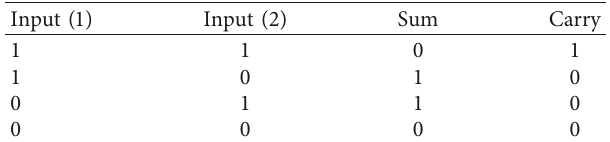
Table 2: A table to define a function for the addition of two one-bit numbers in binary arithmetic, with provision for the carrying out of one